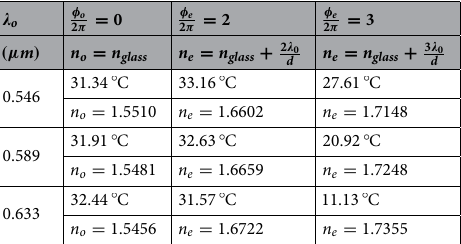
Table 1. The ordinary and extraordinary refractive indices of a 5CB sample at three different wavelengths at various temperatures when the visibilities have theoretically fallen to zero.